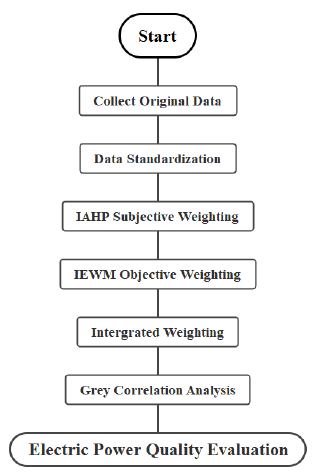
Fig. 1. Power quality assessment